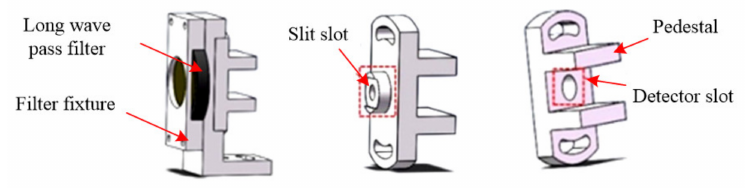
Figure 19. The components of the detection system.